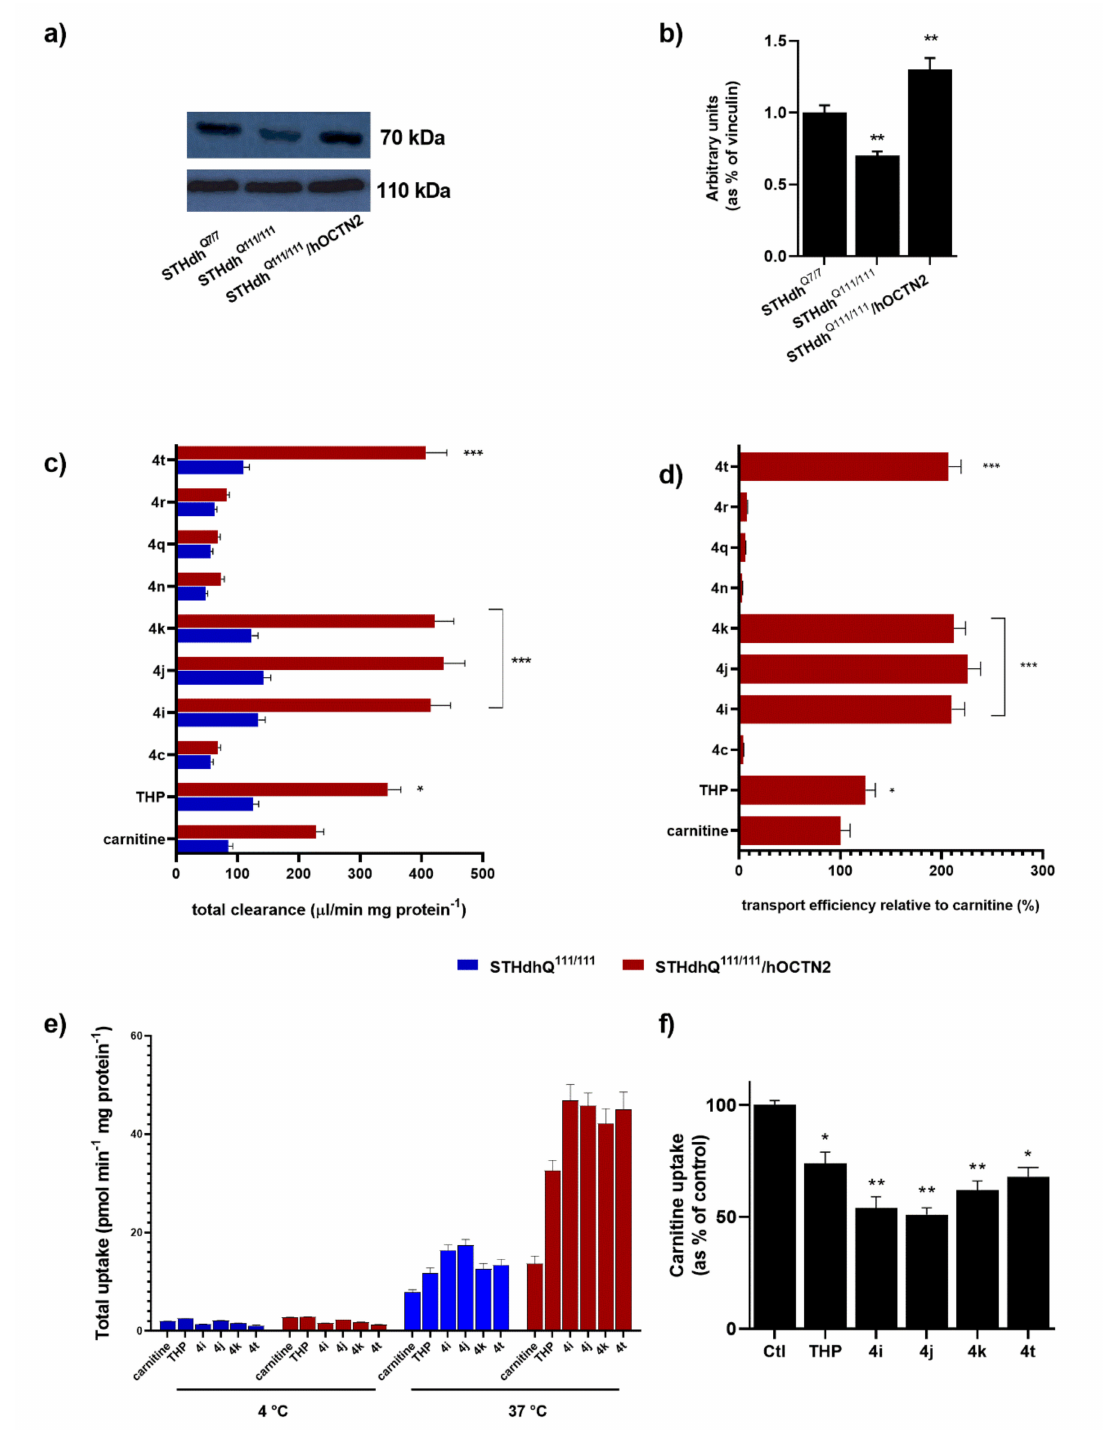
Figure 2. ( a , b ) Western blot analysis of hOCTN2 expression in STHdh Q7 / 7 , STHdh Q111 / 111 , and transfected STHdh Q111 / 111 (STHdh Q111 / 111 / hOCTN2). §§ p < 0.01 vs. STHdh Q7 / 7 . ( c ) The total accumulation of carnitine (10 µ M), THP, or TCL (50 µ M) in STHdh Q111 / 111 cells with or without the heterologous expression of hOCTN2. ( d ) The e ffi ciency of the transport of drugs by hOCTN2 in STHdh Q111 / 111 cells with the heterologous expression of hOCTN2. ( e ) Accumulation at 37 ◦ C or at 4 ◦ C of carnitine, THP, or TCL in STHdh Q111 / 111 cells with or without the heterologous expression of hOCTN2. ( f ) Carnitine uptake in OCTN2-transfected STHdh Q111 / 111 cells in the presence of 50 µ M THP, and the newly synthesized compound. The bars represent the mean ± standard deviation ( n = 3). Statistical significance: * p < 0.05, ** p < 0.01, *** p < 0.001 vs.